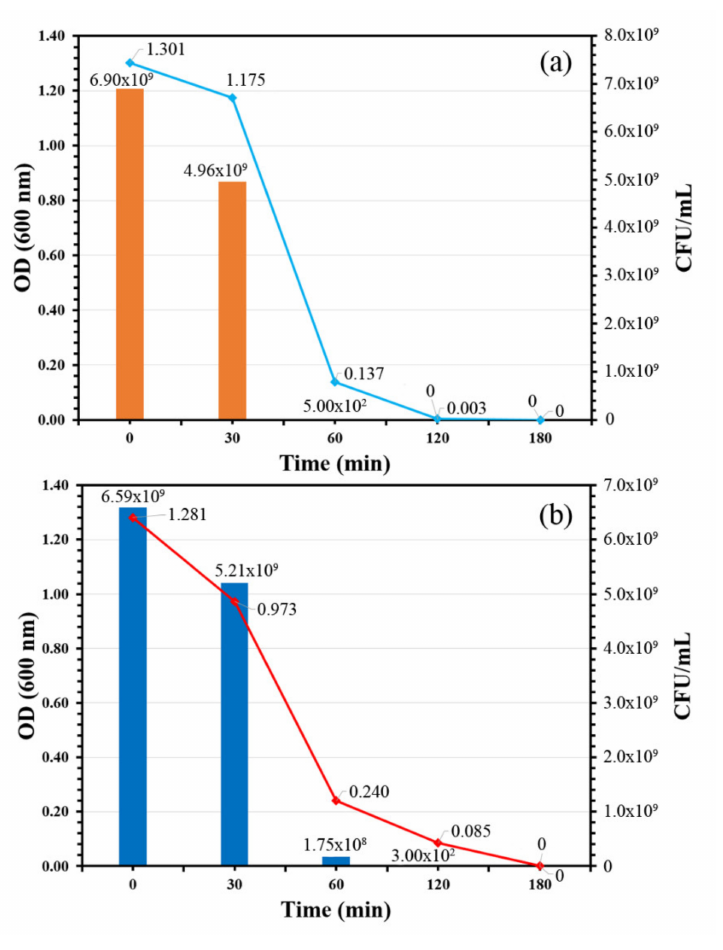
Figure 8. Time-killing curves of TiO 2 -coated PVC: ( a ) E. coli and ( b ) S. typhimurium .